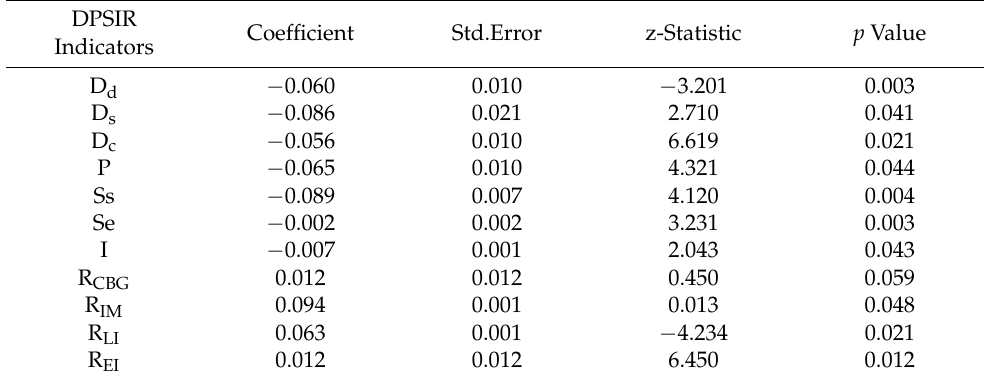
Table 2. The empirical results of the Tobit